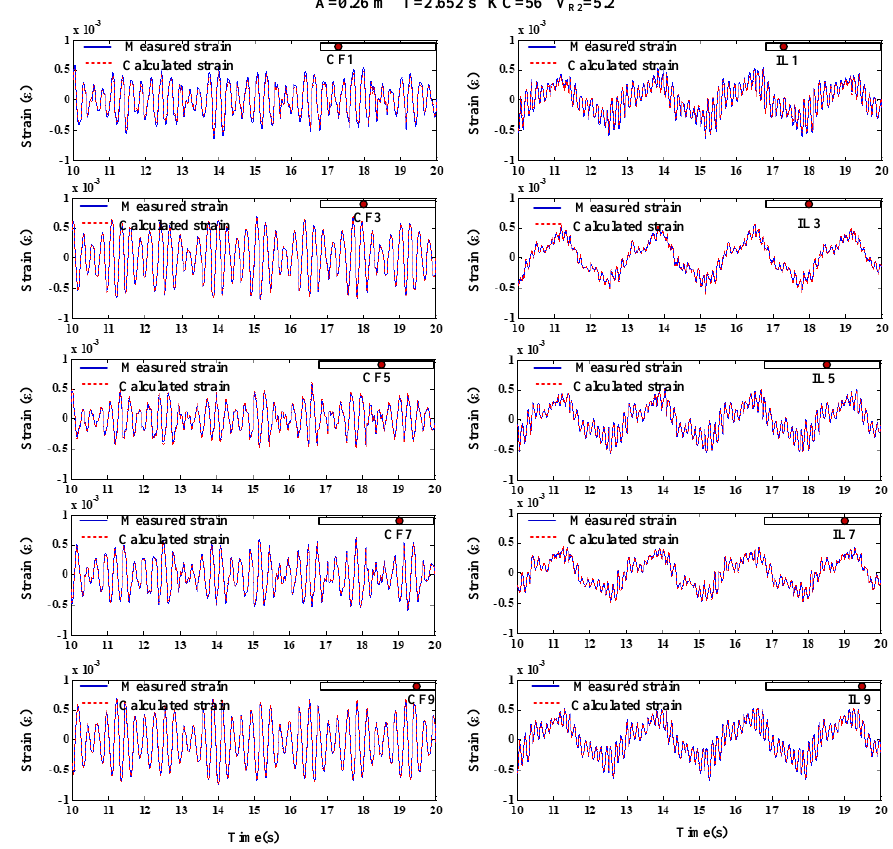
Figure 5. Time history of measured and calculated strain at different gauge points in both the CF and IL directions for KC = 56 and V R2 = 5.2.